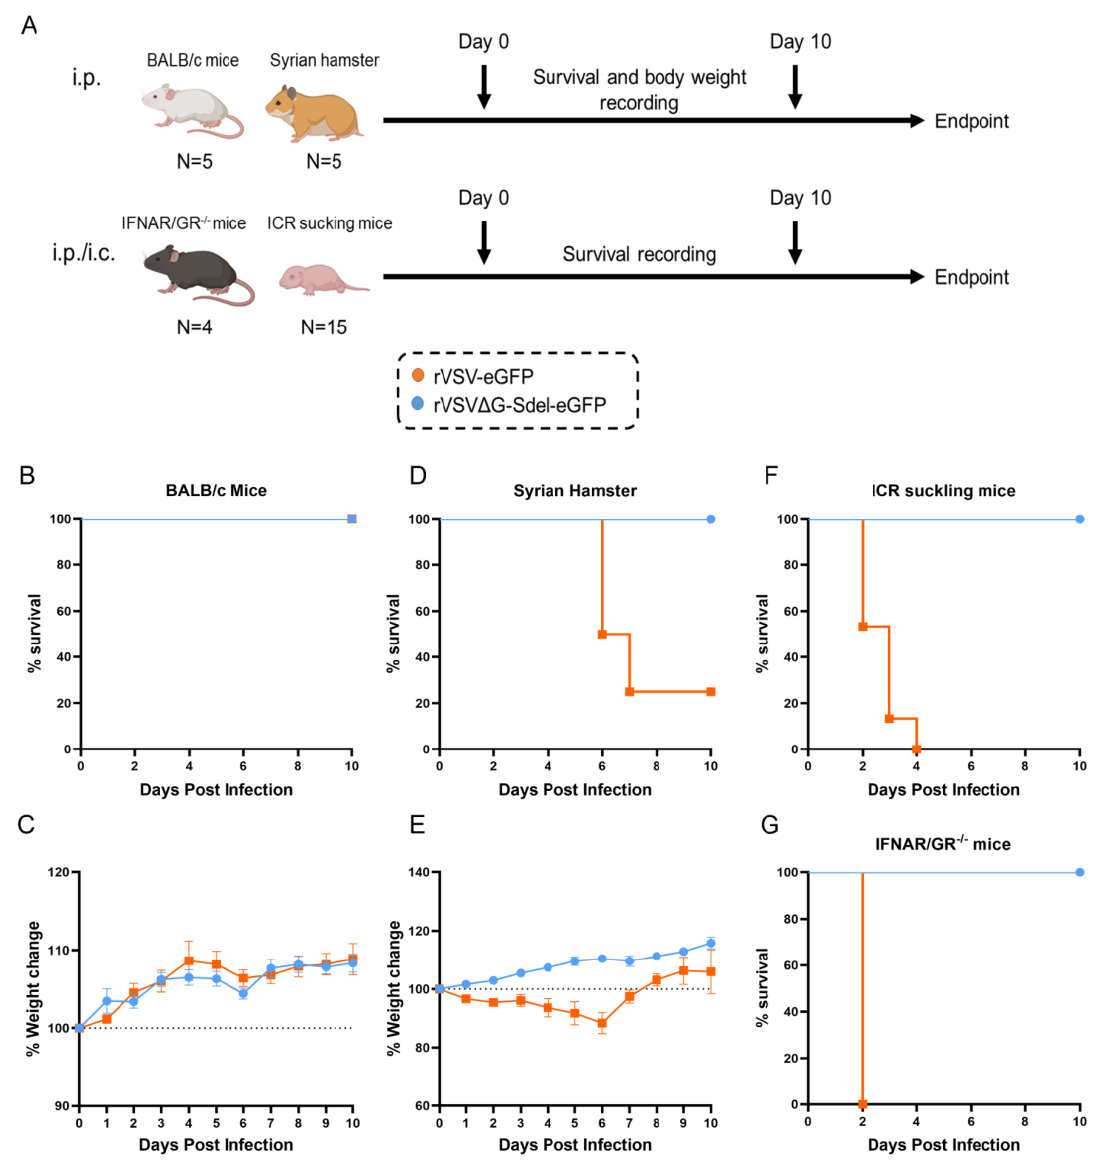
Figure 4. Body weight changes and survival curve of animals post rVSV ∆ G-Sdel-eGFP infection. ( A ) Safety evaluation procedure of animal. Animals were intraperitoneally or intracranially adminis- trated with rVSV ∆ G-Sdel-eGFP on Day0. Survival rate and body weight changes of animals were monitored for 10 consecutive days post-infection. ( B , C ) The survival rate and weight change of BALB/c mice ( n = 5). ( D , E ) The survival rate and weight change of Syrian hamsters ( n = 5). ( F ) The survival rate of ICR suckling mice ( n = 15). ( G ) The survival rate of IFNAR/GR − / − mice ( n = 4). rVSV-eGFP infection served as the control group. Data represent the mean ± standard error of the mean (SEM). The dotted line indicates the percentage of initial weight.